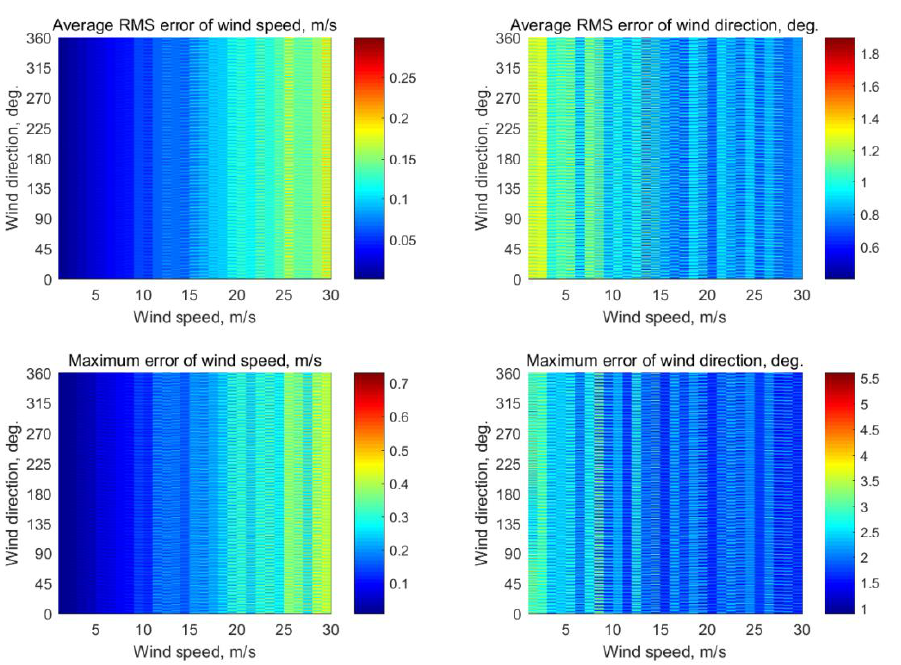
Figure A7. Simulation results of the use of only one incidence angle of 60° for wind retrieval.